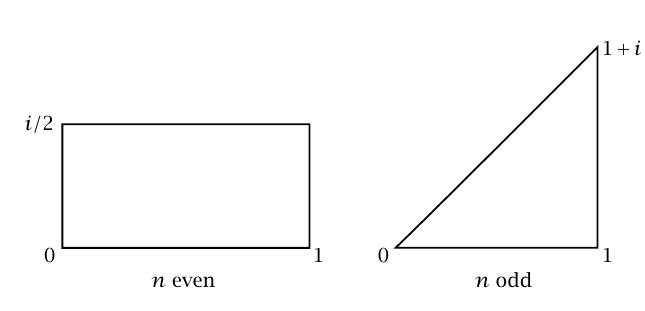
Figure 3.1 . Illustration of Ω ω